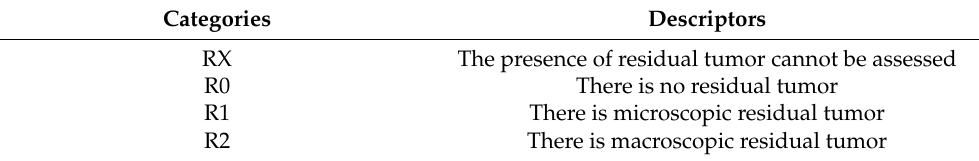
Table 1. Residual tumor classification.